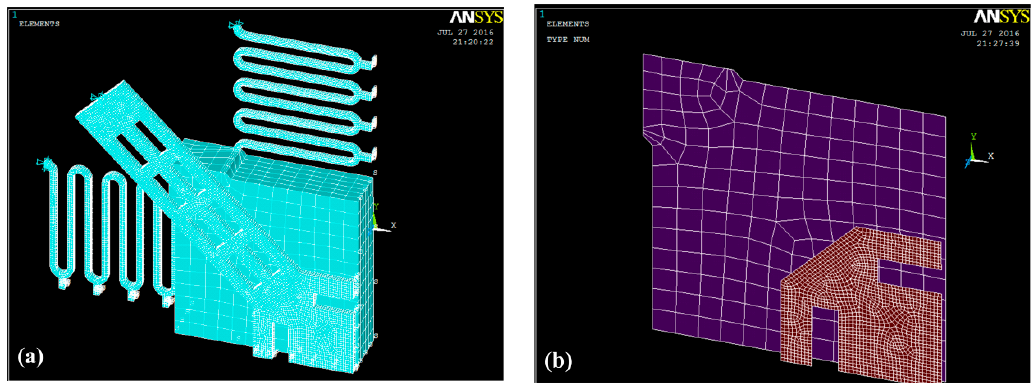
Figure 4. ( a ) ANSYS finite element simulation model of the inertial microswitch in sample 1; ( b ) its contact pair in sample 1.